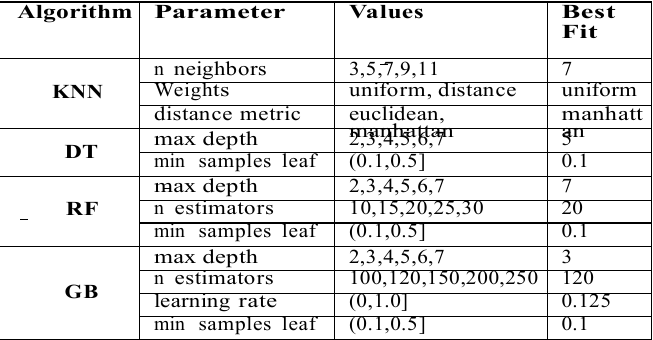
Table 6 . ML configurations for K Nearest Neighbor (KNN), DecisionTree(DT), Random Forest(RF), GradientBoost